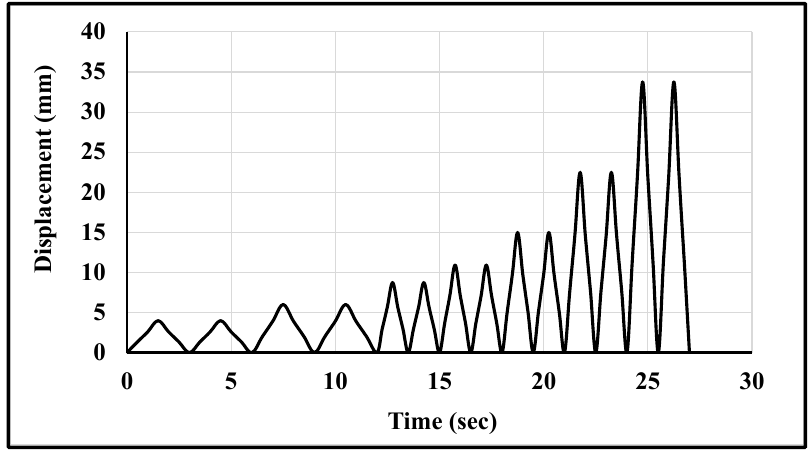
Figure 3. Cyclic loading protocol applied to the wallettes. Table 2. Cyclic loading protocol derived from monotonic loading (Adapted from [16,17,64]).